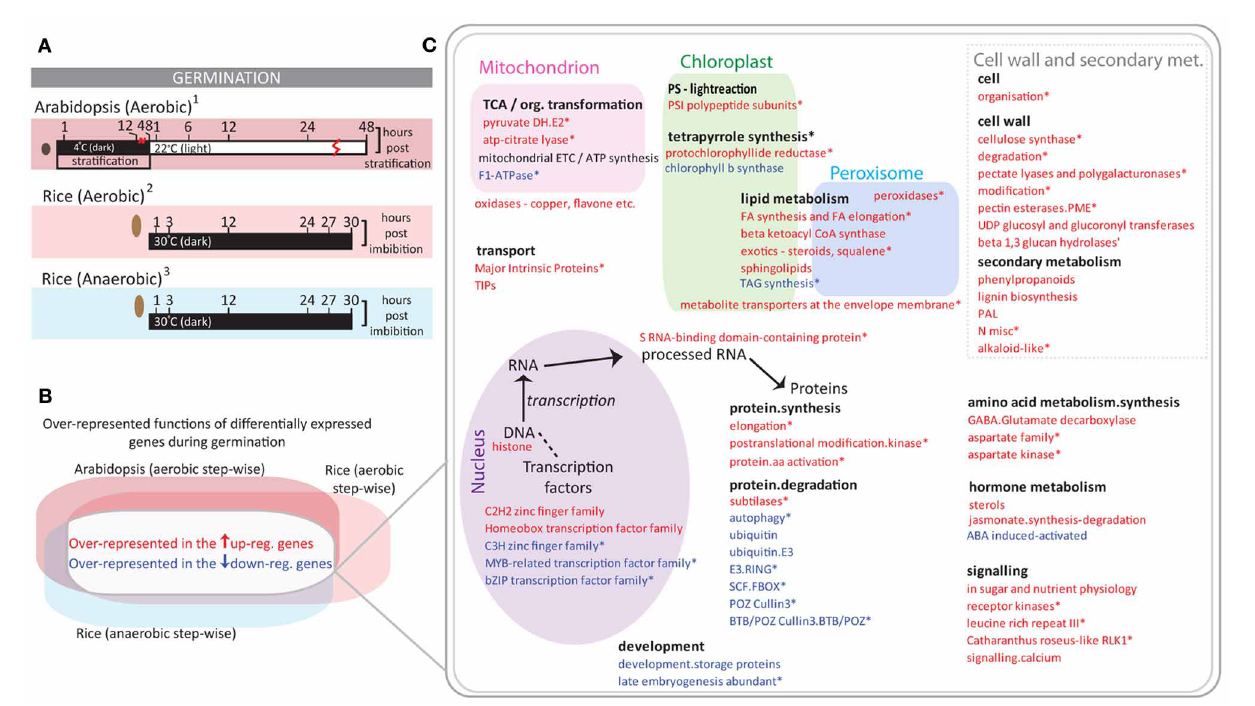
FIGURE 1 | Oxygen independent transcriptomic changes during rice germination. (A) Step-wise comparisons were carried out over the course of aerobic germination in Arabidopsis ( 1 Narsai et al., 2011a) aerobic germination in rice ( 2 Howell et al., 2009) and anaerobic germination in rice ( 3 Narsai et al., 2009). (B) The differentially expressed genes ( > 2-fold, p < 0 . 05, PPDE > 0.96) were analyzed for common over-representation of functions in the up/down-regulated